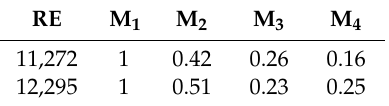
Table 5. Averaged modal contributions ratio to mode 1 contribution, L = 125 mm.